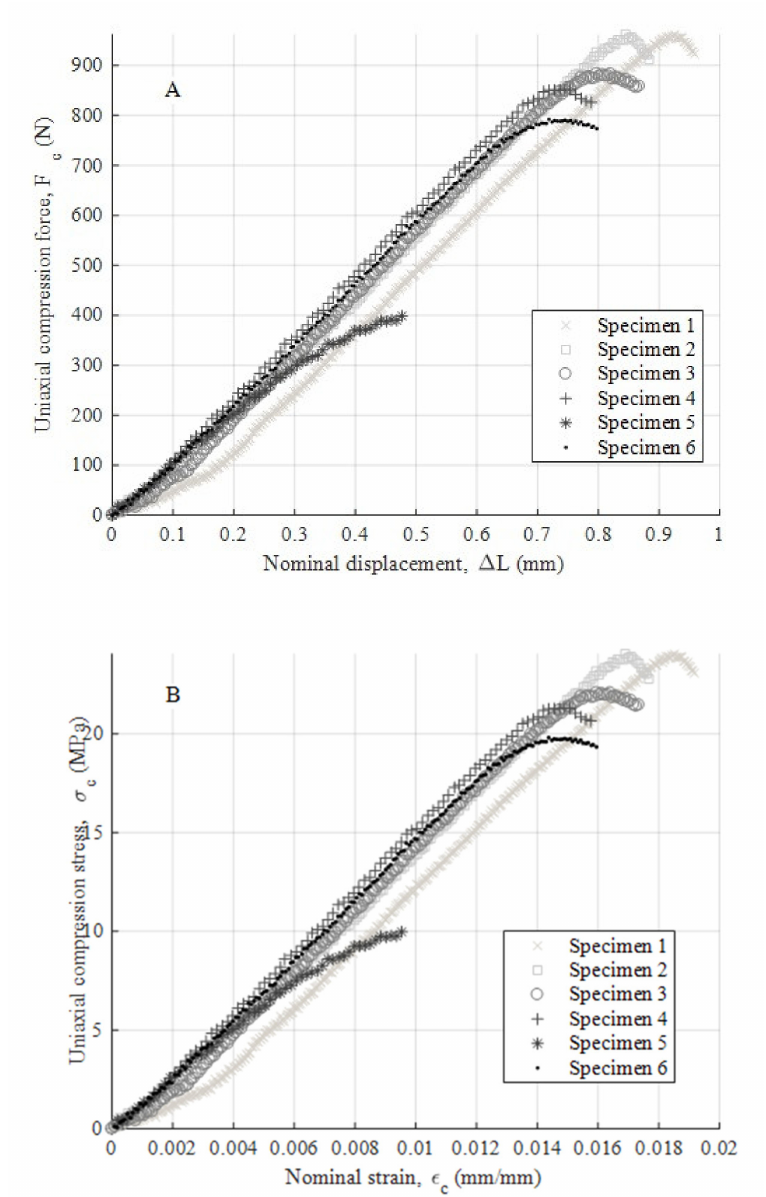
Figure 9. Curves for X-axis specimens related to compression force versus nominal displacements ( A ) and compression stress versus nominal strain ( B